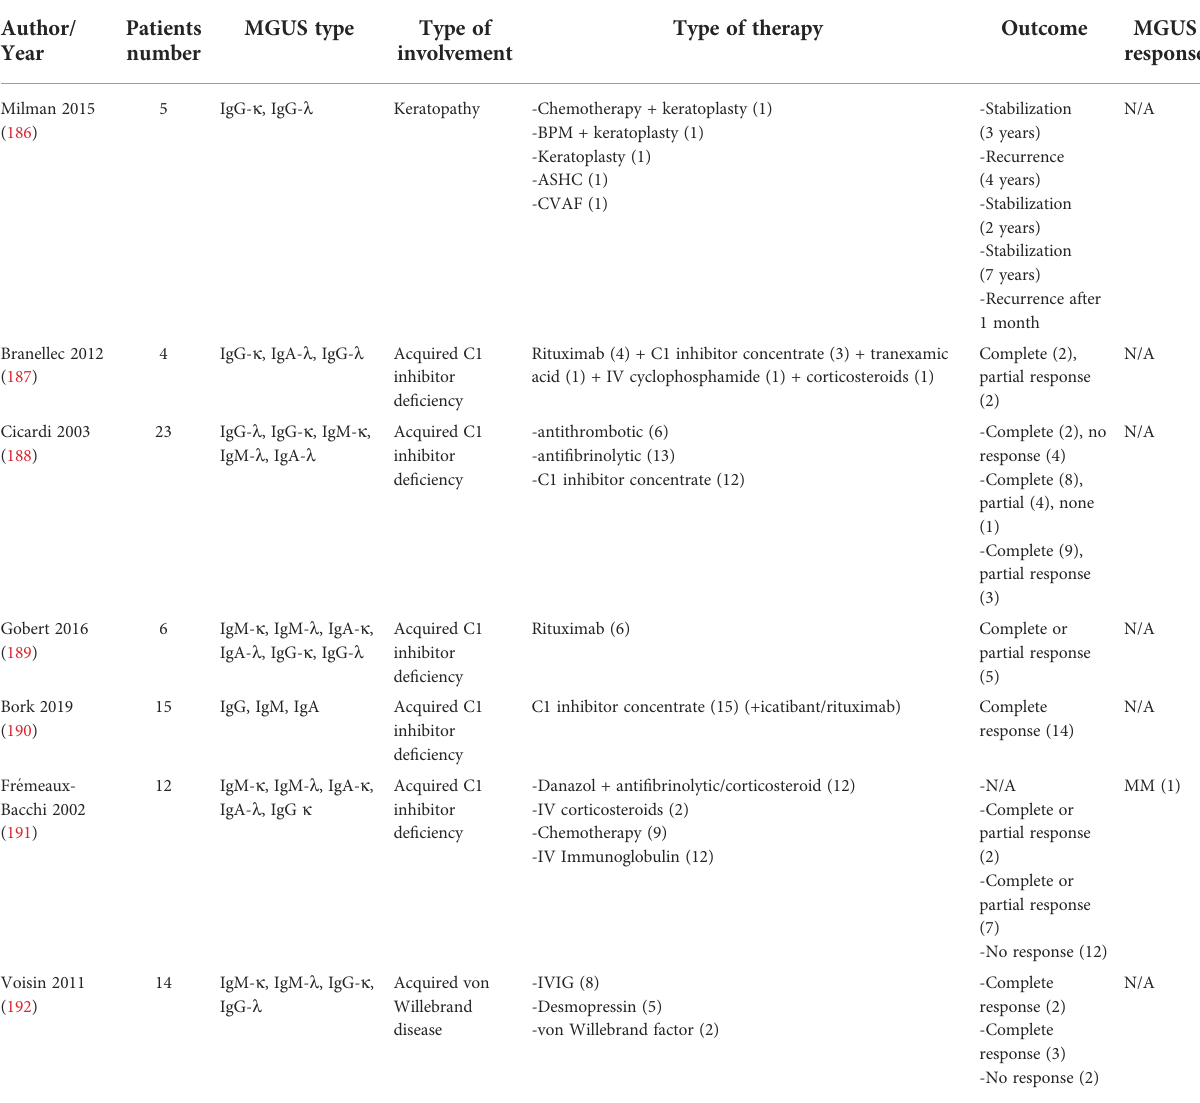
TABLE 4 Literature review on other MGUS-related